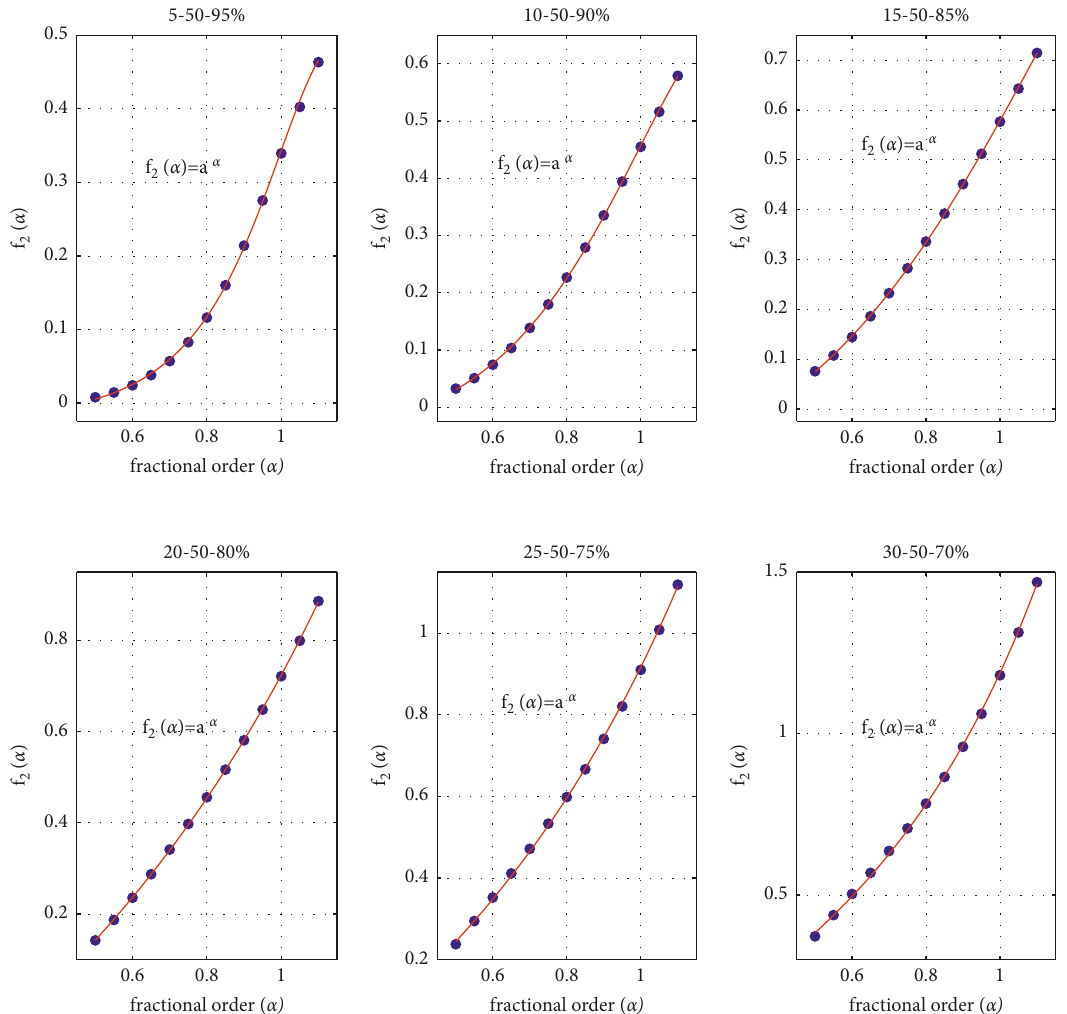
Figure 6: Data sets { α , a α }, where a is defined in (33) and x � 5, 10, 15, 20, 25, and 30, and results of curve fitting for f